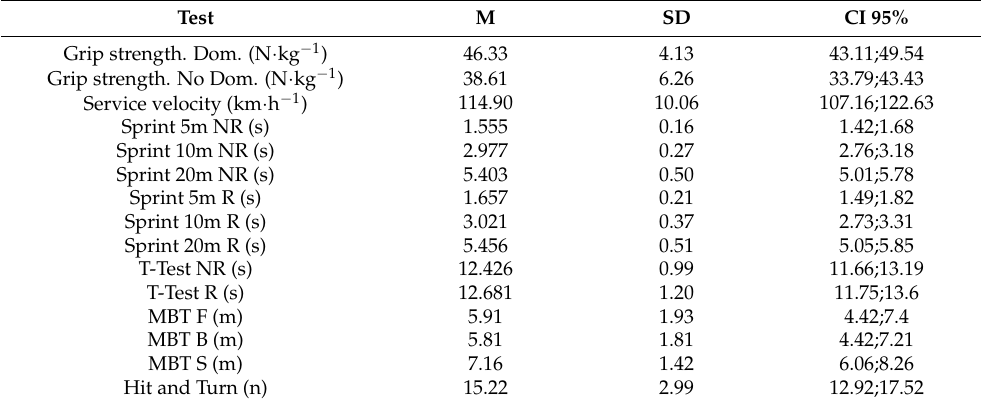
Table 3. Mean (M), standard deviation (SD) and confidence interval (CI) of physical test measurements.